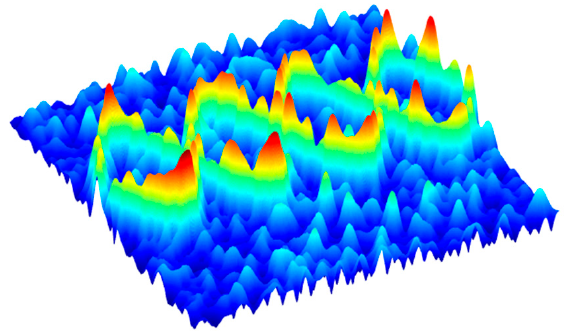
Figure 2. TFR of micro-Doppler signals.